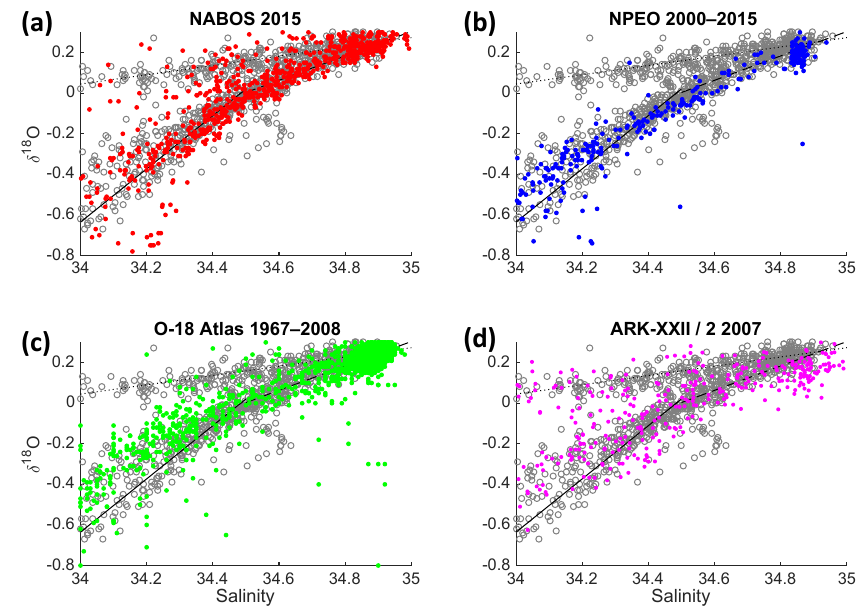
Figure 6. Comparison of data and linear regressions defining the SIM, MW, and lower MW branches defined during the 2013 cruise against additional data sets collected within the study region and in the deep basins of the eastern Arctic (Nansen, Amundsen, and/or Makarov basins): (a) 2015 cruise; (b) North Pole Environmental Observatory (NPEO); (c) Oxygen-18 Database; and (d) ARK-XXII/2 expedition. In each panel, the 2013 data are plotted as gray circles and the linear regressions are plotted as dotted (SIM branch), dashed (MW branch), and solid (lower MW branch) lines. Data from each of the four cruises are plotted as (a) red, (b) blue, (c) green, and (d) magenta dots to indicate the general correspondence of these data with the mixing regimes defined by the three branches. Station locations corresponding to each data set are shown in Fig. 2. The NPEO data were previously published by Alkire et al. (2015) and can be accessed online at the NSF Arctic Data Center (https://arcticdata.io). The 2015 NABOS cruise data can be accessed online at the NSF Arctic Data Center. Data from the Oxygen-18 Database (Schmidt et al., 1999) were restricted to longitudes 65–160 ◦ E and latitudes 75–90 ◦ N to closely resemble the area sampled for this study. The data can be accessed online at https://data.giss.nasa.gov/o18data/. Data from the ARK-XXII/2 cruise aboard the Polarstern were published by Bauch et al. (2011) and can be accessed online via PANGAEA